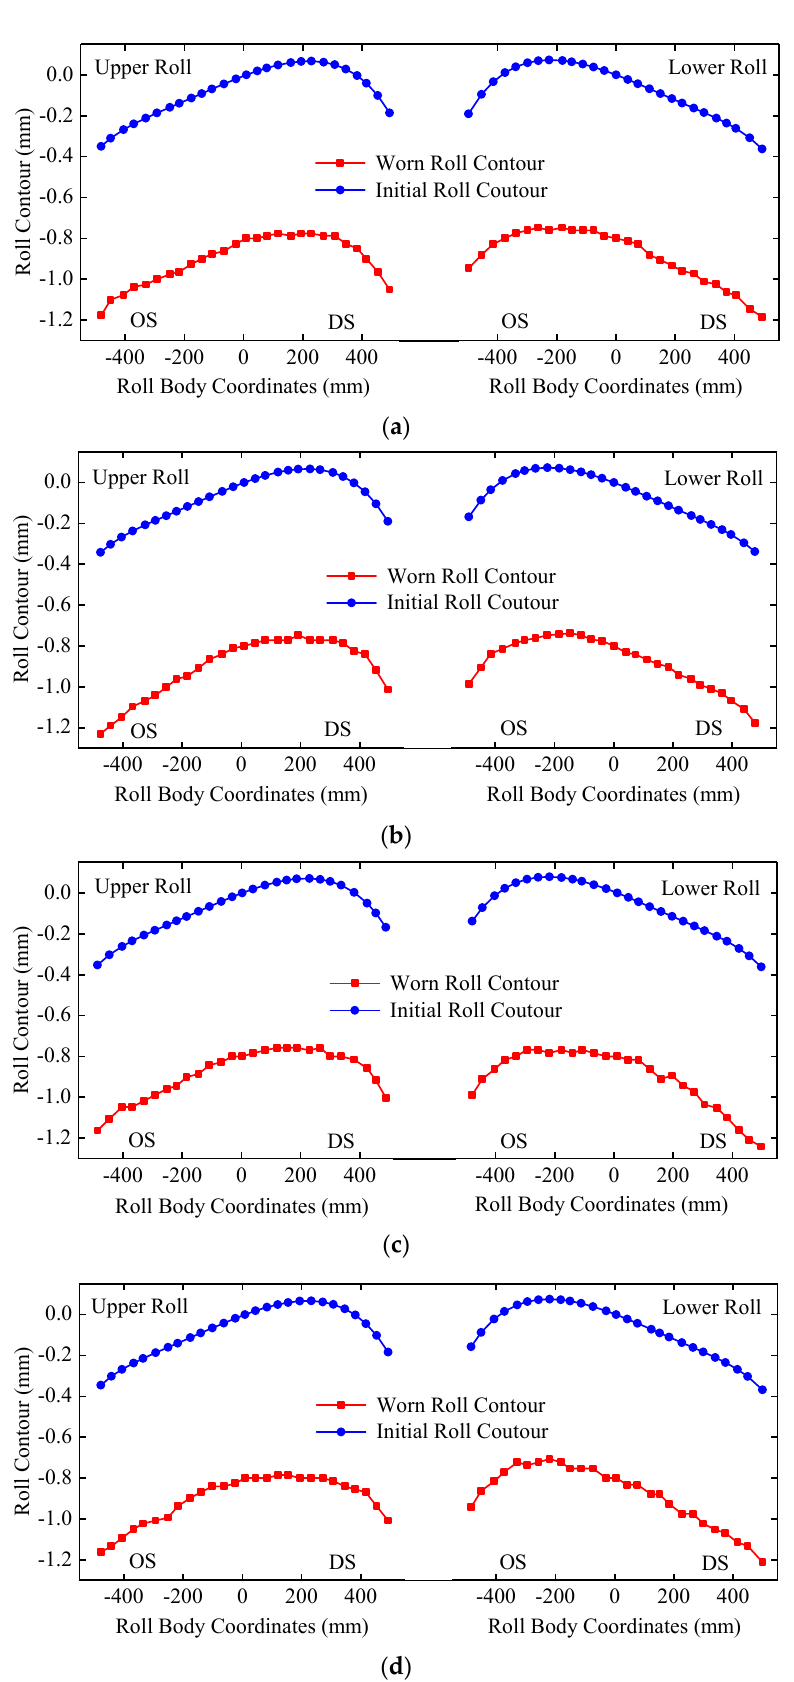
Figure 15. Worn roll contour of the back-up roll: ( a ) F1 stand; ( b ) F1 stand; ( c ) F2 stand; ( d ) F2 stand. Table 9. Index of the strip profile.